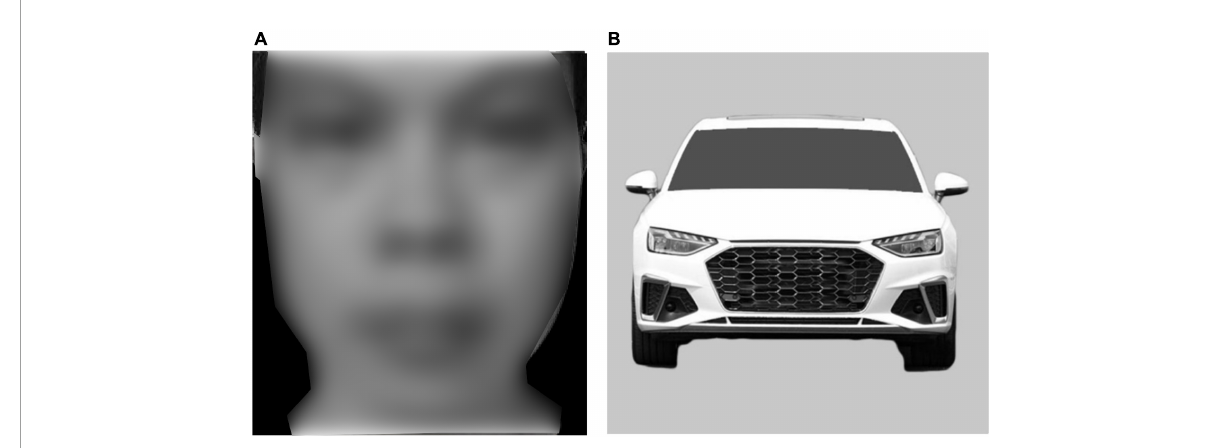
FIGURE1 Examples of stimuli. (A) Face. (B) Car front pictures. The example of the face is one of the authors who has authorized the usage of the face. This face is not used in the experiment, but to show the sample of our